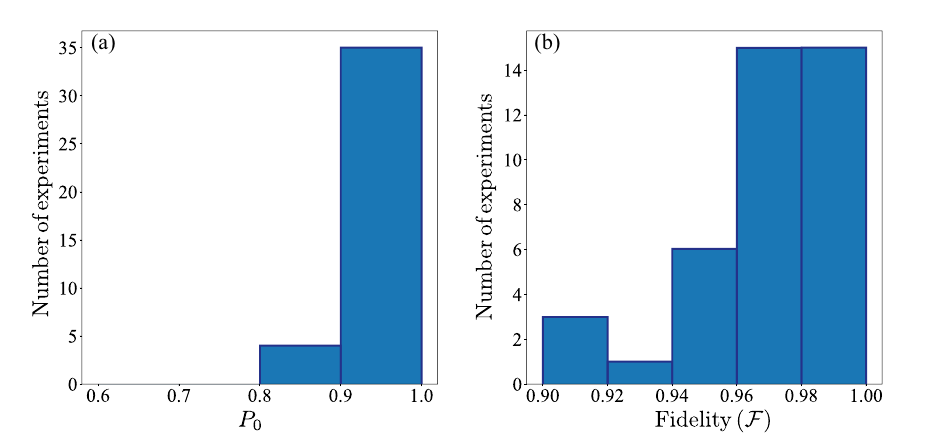
Figure 3. Histograms for the results of 40 independent experiments. with τ Histogram for the probability to obtain m = 0 . ( b ) Histogram for the fidelity between the agent and the nearest eigenvector using Eq. (17).